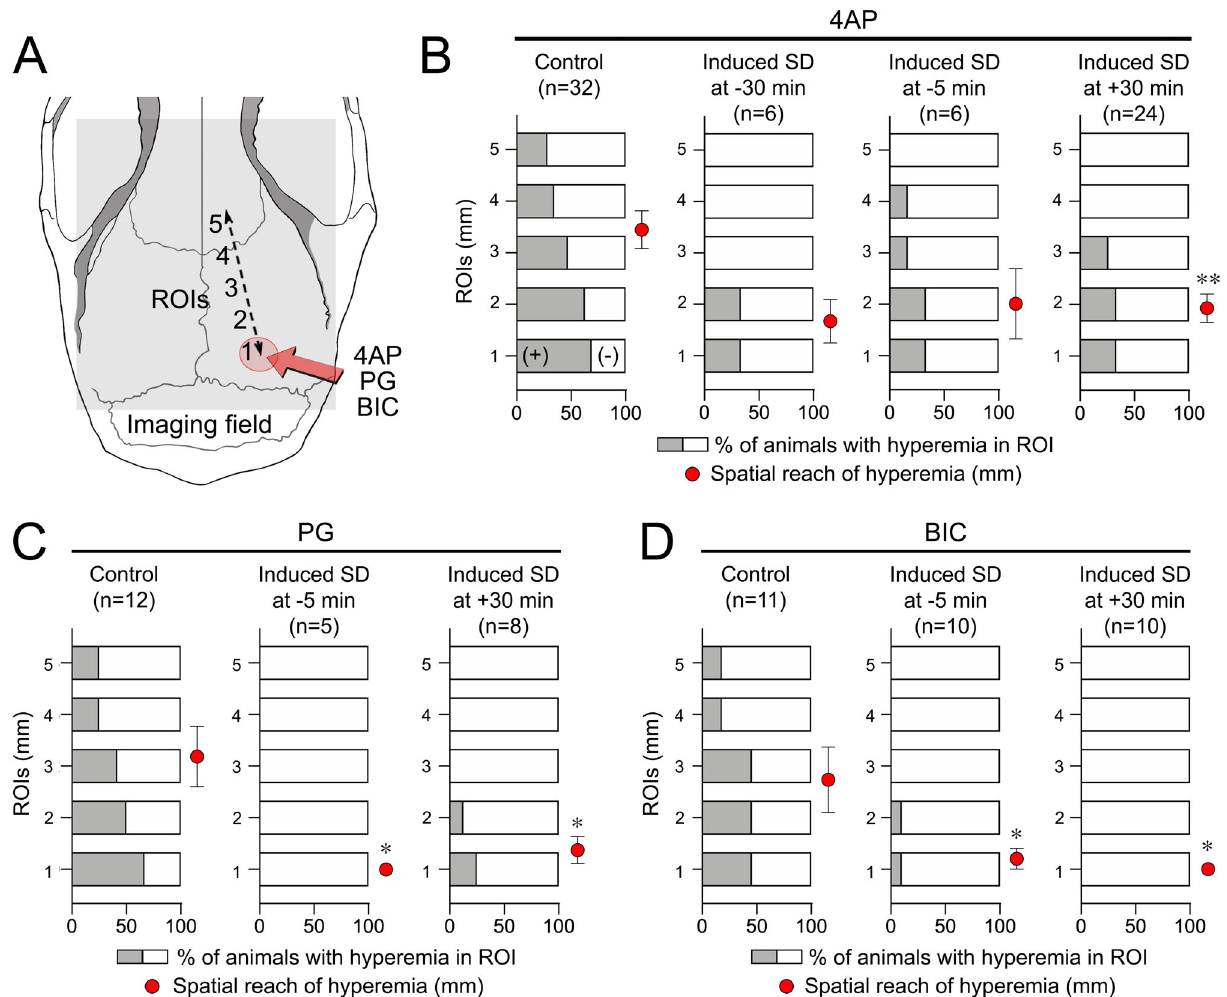
Fig. 7 SD limits the spatial reach of seizures across the cortex. A Diagram showing the ROI placement for IOS analysis. B – D The proportion of animals that developed hyperemia within each of the fi ve ROIs coupled to 4AP, PG, or BIC seizures show that the spatial reach of seizures was diminished by an SD induced 30 min before ( − 30 min), 5 min before ( − 5 min) or 30 min after ( + 30 min) drug application. All SDs were remotely induced by topical KCl application using the setup shown in Supplementary Fig. 1B, b. The control group did not receive any SD intervention from outside, but 22 animals in 4AP, 3 animals in PG, and 1 animal in the BIC control group developed spontaneous SDs (as summarized in Fig. 3A, B). Red circles indicate the average distance hyperemic transients reached from the drug application site in each subgroup (no hyperemic transients in any ROI is 0 mm). *-** p < 0.05-0.01 vs. control, one-way ANOVA followed by Dunnett ’ s multiple comparison ’ s tests